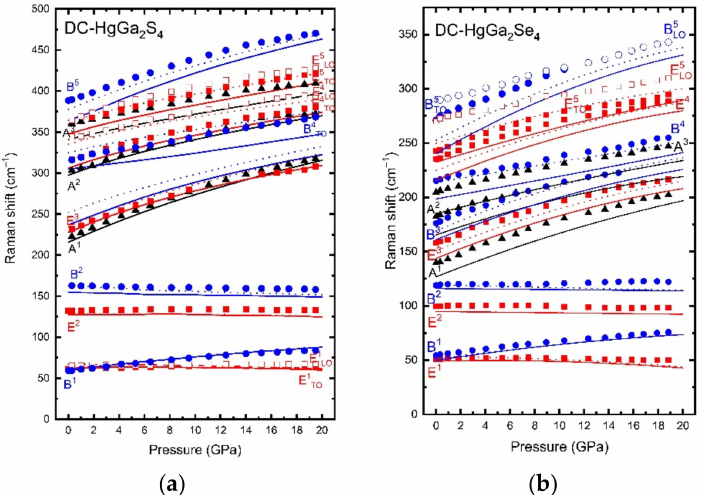
Figure 2. Pressure dependence of the experimental (symbols) and theoretical (lines) Raman-active frequencies in DC- HgGa 2 S 4 ( a ) and DC-HgGa 2 Se 4 ( b ). TO (LO) experimental phonons of pure B and E symmetry are represented by full (empty) symbols. Theoretical calculations for the TO (LO) phonons of pure B and E symmetry are represented by solid (dotted) lines. A, B, and E modes show black, blue, and red colors,